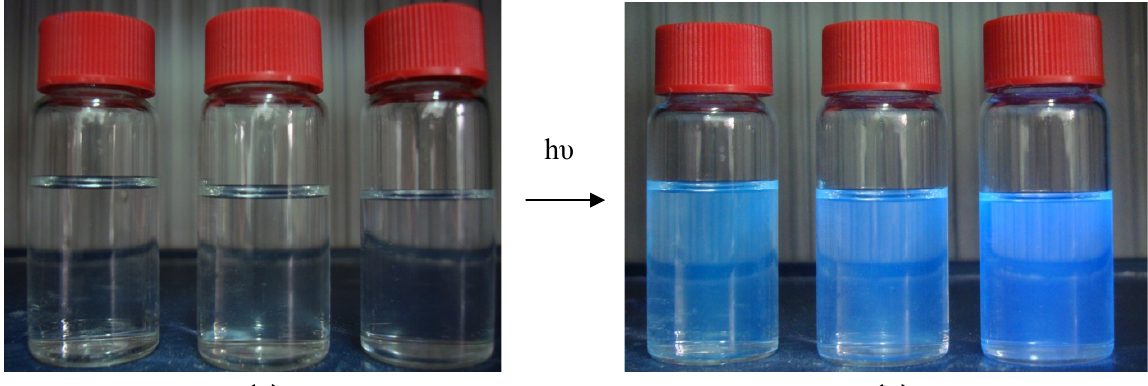
OH, CH CN and CH Cl, 3 3 3